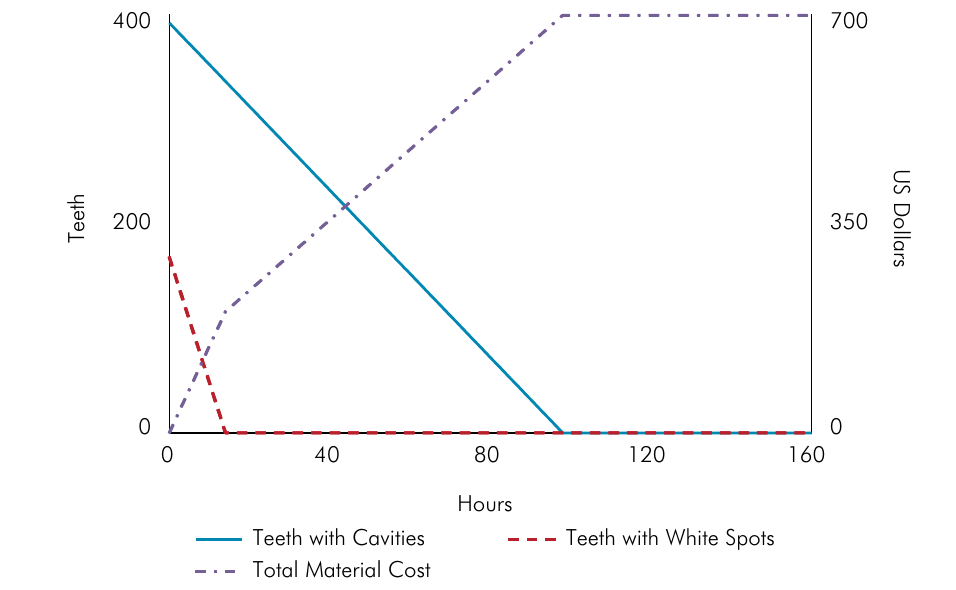
Figure 3. System Dynamics Model demonstrating the relationship between clinical time and cost required to control dental caries conducted by a local oral health